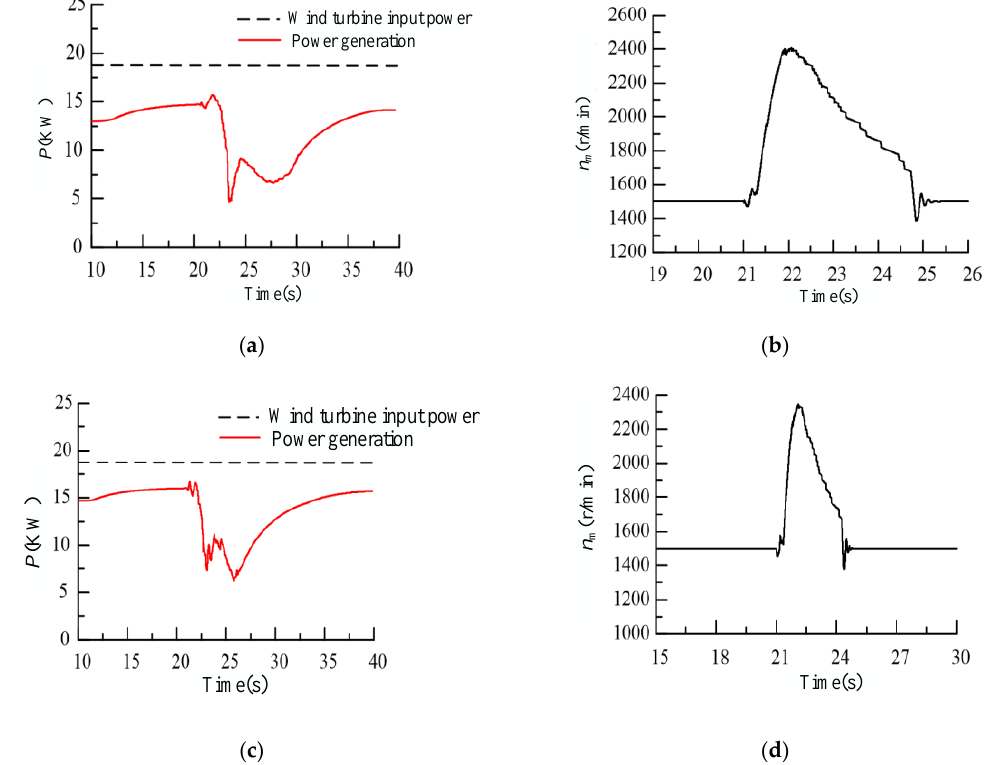
Figure 9. LVRT simulation curve of HWT under traditional control strategy. ( a ) HWT power curve with 80% single-phase drop; ( b ) Single-phase drop 80% motor speed curve; ( c ) HWT power curve with 20% three-phase drop; ( d ) Three-phase drop 20% motor speed curve.